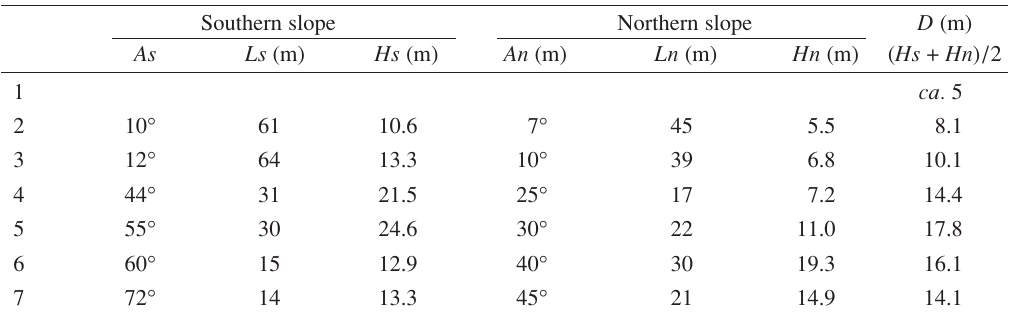
Table I. Slope angle of the bank and the depth of the seven